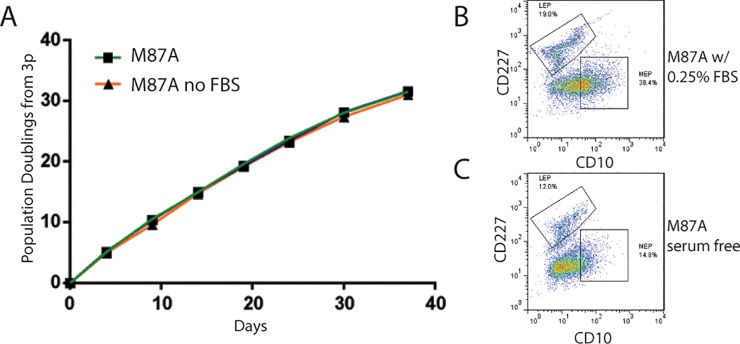
Effect of growth and lineage diversity in pre-stasis HMEC in M87A ± fetal bovine serum.(A) Curves showing PD as a function of time in days for 240L grown in M87A with and without 0.25% FBS from 3p. Growth rates were only assessed to 10p, thus the curves to not reflect cultures reaching stasis. Pseudocolor dot plots representing flow cytometry measurements of CD227 and CD10 expression in 4p HMEC cultured in (B) regular M87A media or (C) M87A without fetal bovine serum (which is normally at 0.25%). Whereas growth rates are identical with or without serum, LEP cells are lost more rapidly in serum-free M87A.